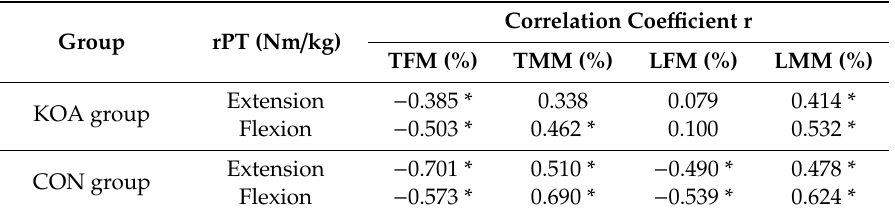
Table 4. Correlation between the relative peak torque of the knee joint and body composition of participants between the KOA and CON